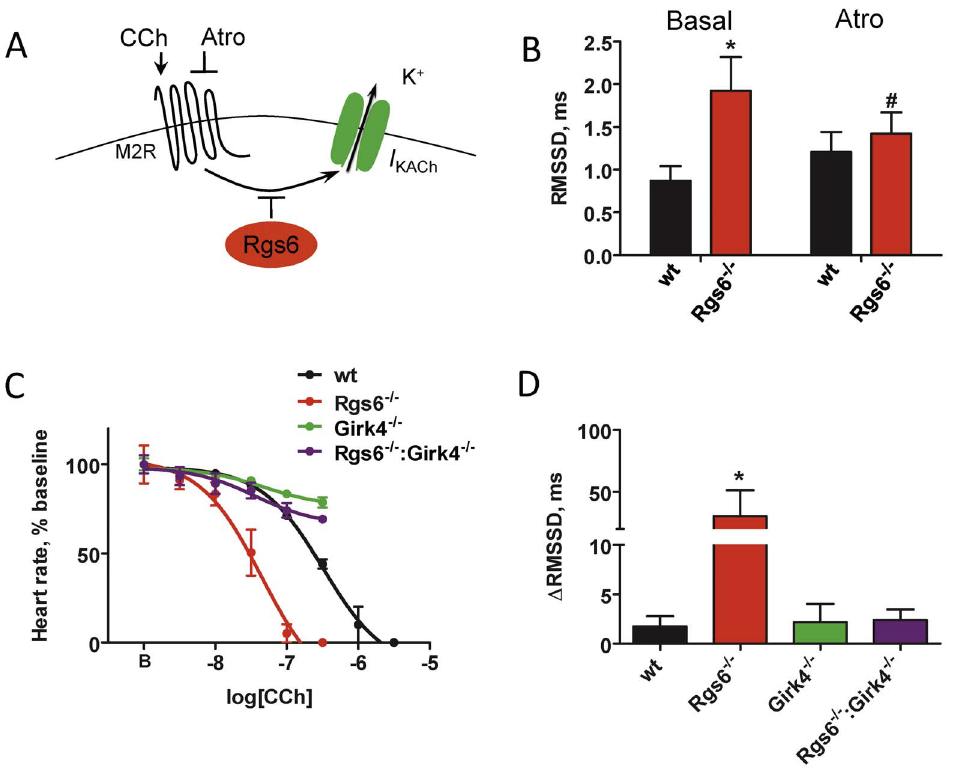
Figure 2. The effects of the Rgs6 on HRV are mediated by the I KACh and are influenced by the m 2 R activity. A, Schematic representation of the pathway targeted both genetically and pharmacologically. Abbreviations are: atropine (Atro), carbamylcholine (CCh). B, Effect of m 2 R blockade by atropine on HRV in wild-type (black; n=7) and Rgs6 2 / 2 hearts (red; n=10). No significant effect of drug was observed in wild-type hearts. C, Increased sensitivity of Rgs6 2 / 2 hearts to m 2 R stimulation and its rescue by I KACh ( Girk4 ) ablation. Increasing concentrations of CCh were applied to isolated perfused hearts (n=4–6 per genotype). D, m 2 R stimulation non-proportionately increased HRV in Rgs6 2 / 2 hearts. Hearts (n=3–6 per genotype) were perfused with CCh ( , IC 10 concentration) identified from dose-response studies, followed by measurement of changes in the RMSSD parameters. Symbols: * P , 0.05 vs wild-type, # P , 0.05 vs treatment.